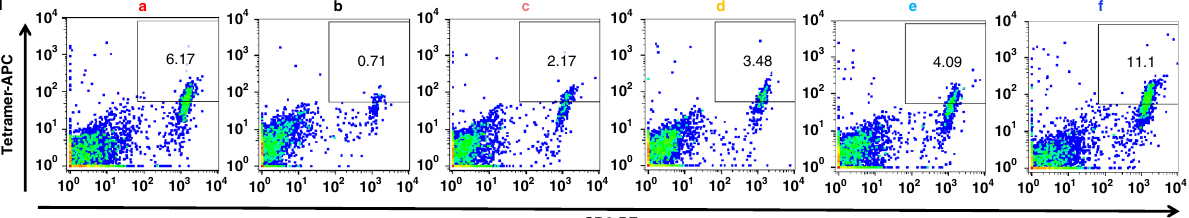
Fig. 5 Antitumour activity and tumour-speci fi c immune response in therapeutic mouse model. a Scheme of (MS@OVA in MOF)@(polyIC in MOF) fabrication. b Scheme of using MOF-gated MS cancer vaccine in combination with anti-PD-1 Ab to stimulate DCs cells activation, enhance cancer antigen – speci fi c T-cell activity in lymph nodes and spleen, release immunological break and inhibit tumour growth. c Timeline of treatment: female C57Bl/6J mice were subcutaneously injected with 2×10 5 cells mouse − 1 of E.G7-OVA cells to establish tumours; On day 3, 7, 14, 21 post-tumour inoculation, mice were administrated with subcutaneous injection of cancer vaccines plus intraperitoneal injection of anti-PD-1 Ab; Tumour growth was continuously monitored. d Kaplan – Meier curve of mice survival (left) and tumour volume (right) after subcutaneous injection of E.G7-OVA cells ( n = 7 independent animals; left, log-rank; right, two-way ANOVA). e , f Population ( e ) and representative fl ow cytometry plots ( f ) of tetramer + CD8 + T cells in splenocytes at the endpoint. Data in e , n = 4 independent animals, one-way ANOVA followed by Tukey ’ s multiple comparisons post hoc test, p <0.0001. All data ( d , right panel; e ) are presented as mean + and 33). Mice treated with (MS@OVA in MOF)@(polyIC in MOF) anti-PD-1 (group g), and OVA/polyIC on MS plus a high dose of plus a high dose of i.p. anti-PD-1 (group i) show a higher i.p. anti-PD-1 (group h). Mice treated with (MS@OVA in MOF) survival rate and a smaller tumour volume, than those @(polyIC in MOF) plus a high dose of i.p. anti-PD-1 (group i) treated with free OVA plus a high dose of i.p. anti-PD-1 (group show the highest tetramer + CD8 + populations in the spleen among all groups. a), only free OVA (group b), OVA on MS plus a high dose of i.p.